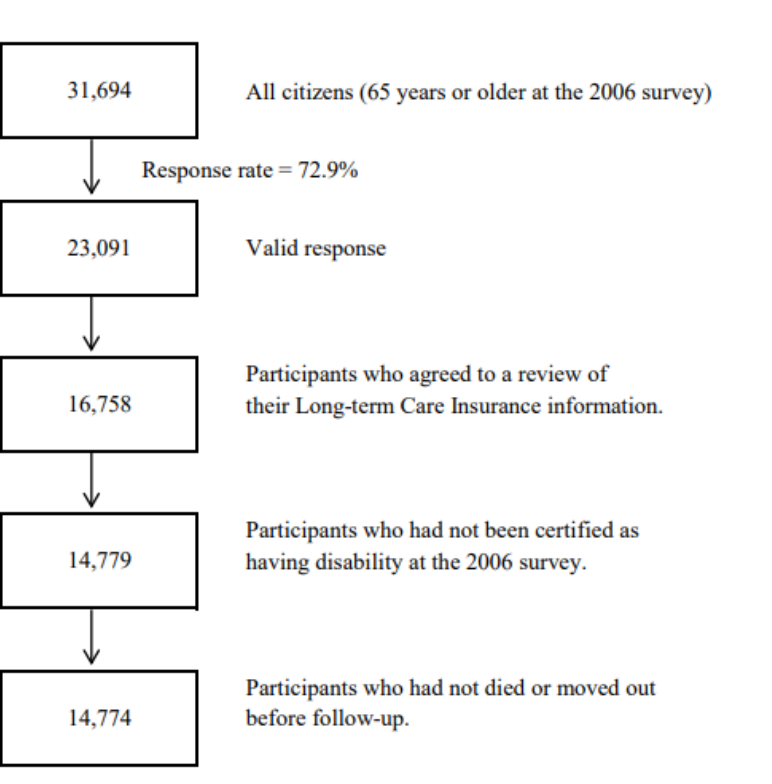
Figure 2. Flowchart of study participants of the Ohsaki Cohort 2006 Study.